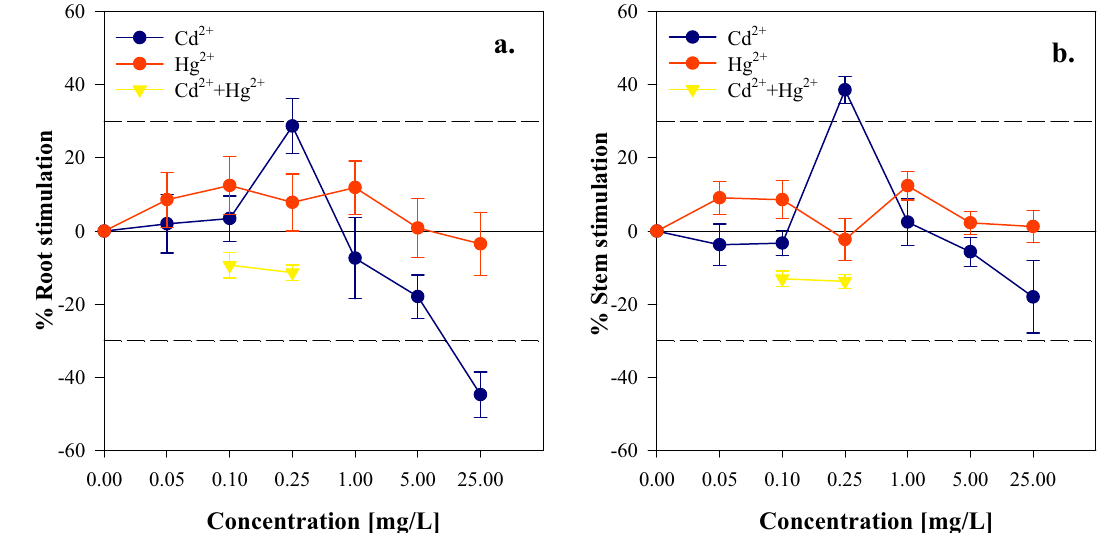
Figure 3. Dose response curve of Cd 2+ Hg 2+ and Cd 2+ –Hg 2+ in elongation of L. perenne ( a ) root stimulation ( b ) stem